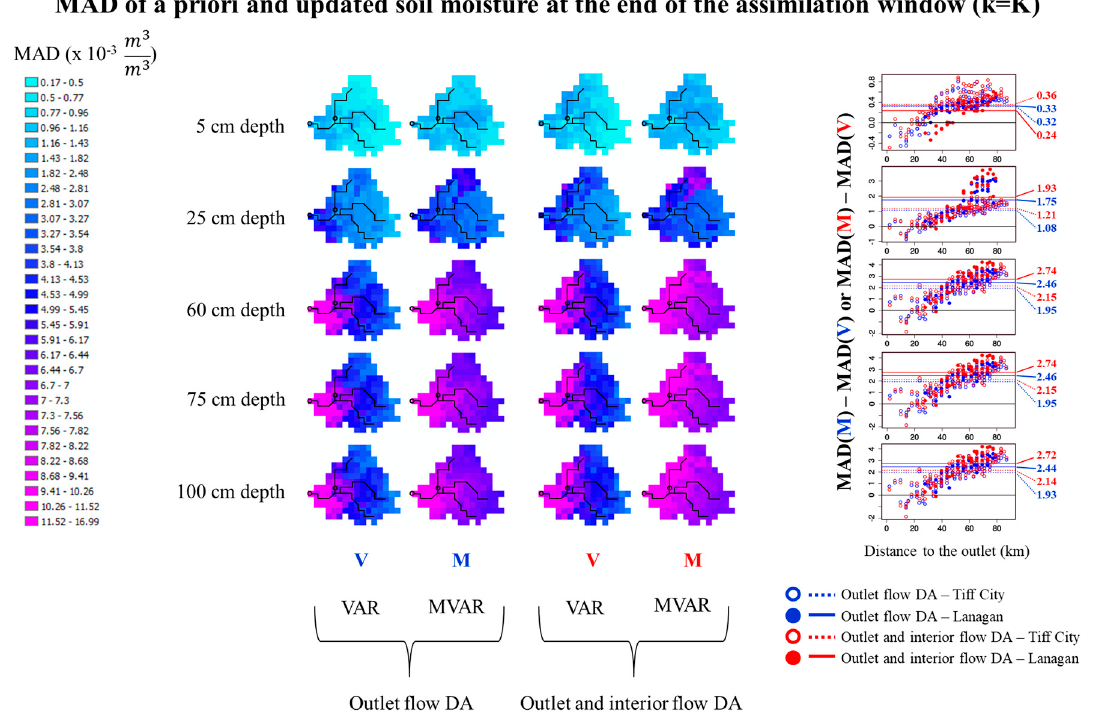
Figure 6. Same as Figure 5 but for depth-specific soil moisture translated from SAC-states via the soil moisture translation routine available in the SAC-HT.